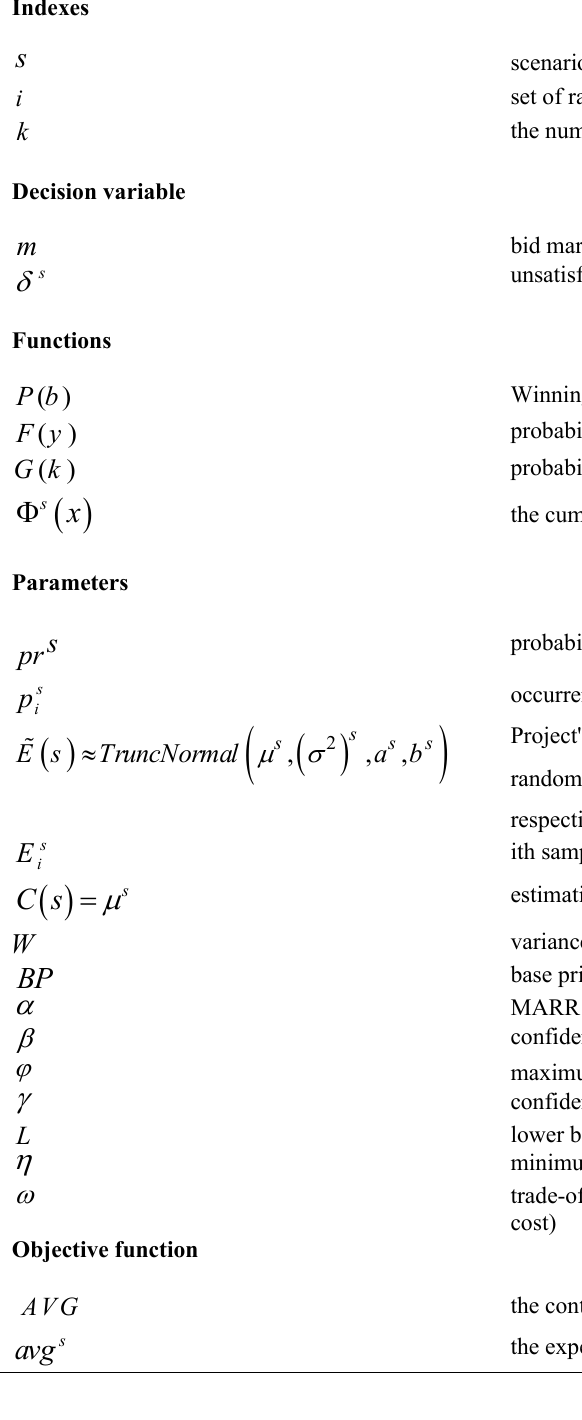
Notations used in the